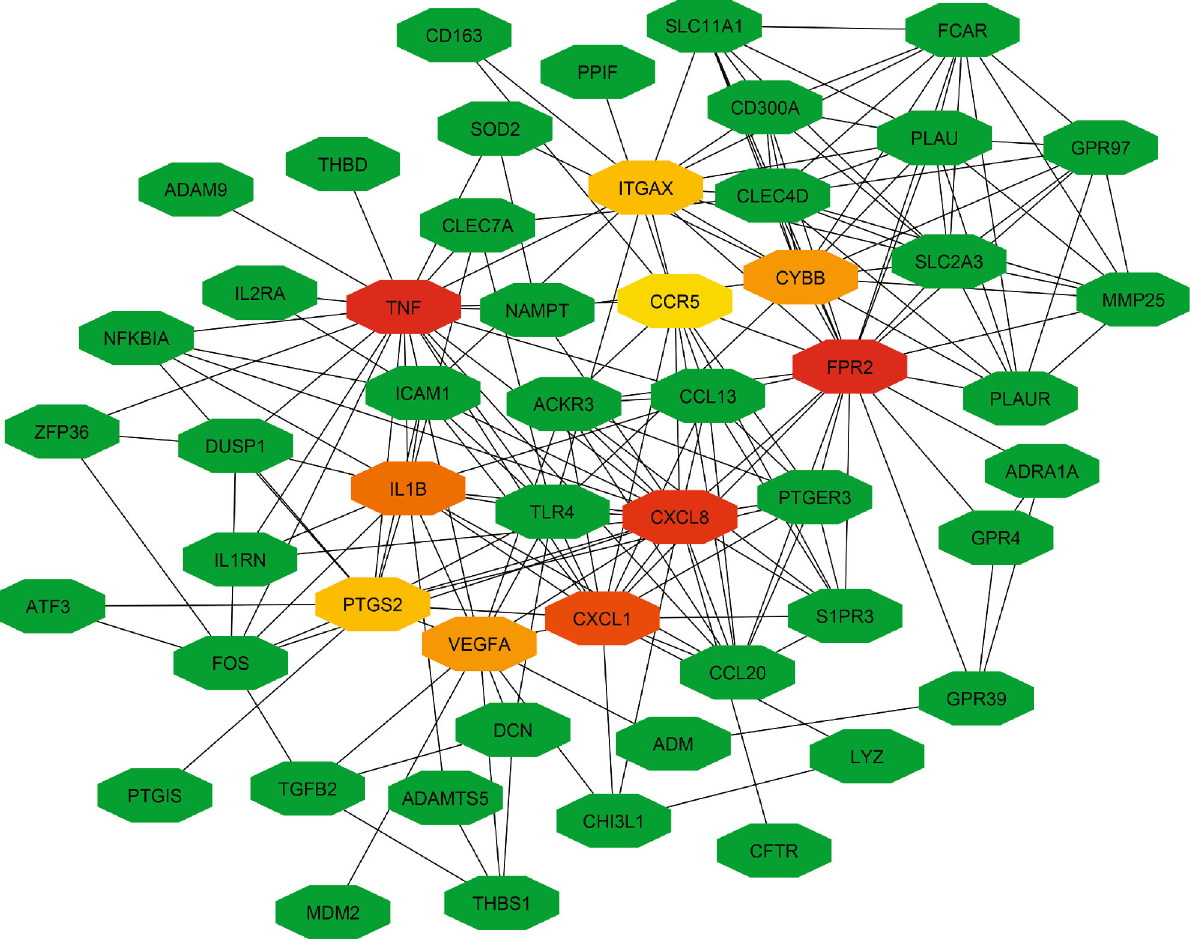
Figure 5: An illustration of the simpli fi ed PPI network and the hub proteins. Ten most signi fi cant hub proteins are marked as red, orange, and yellow color, respectively. Red color indicates highly connected nodes, orange color indicates moderately connected nodes, and yellow color indicates poorly connected